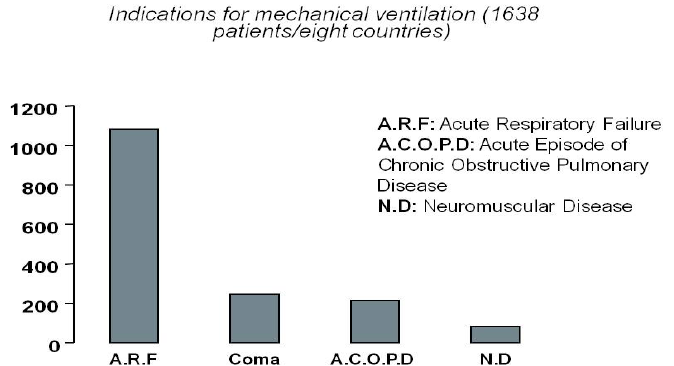
Figure 1. Main indications for mechanical ventilation in the intensive care unit (ICU). The causes leading to the need for mechanical ventilation are much more varied than the causes leading to motor paralysis. Therefore, the amount of patients that might benefit from a patient ventilator interface is considerably larger than the number of patients that might benefit from a motor oriented Brain Computer